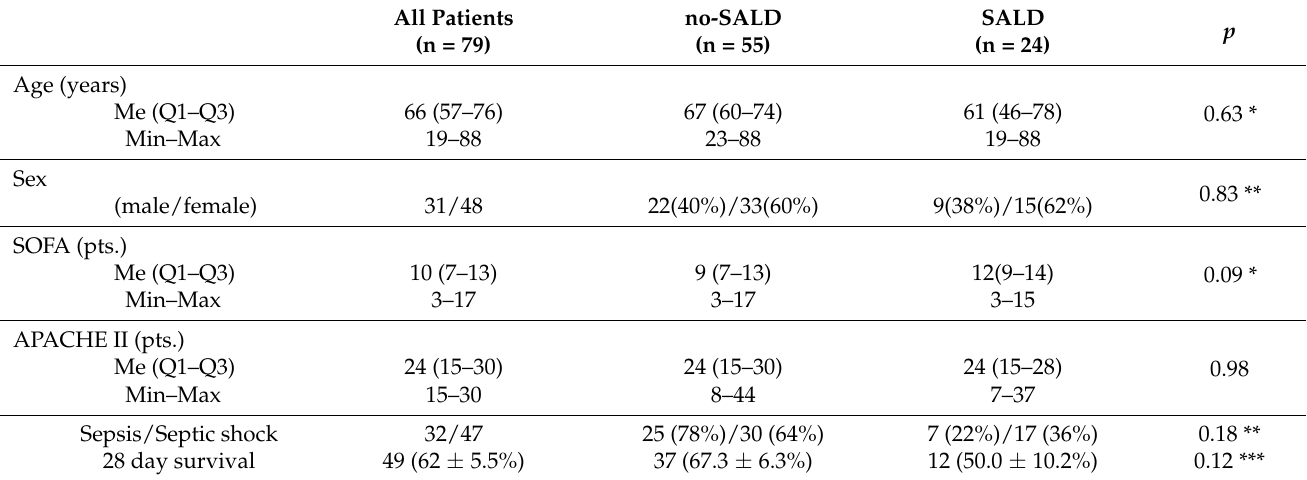
Table 1. Characteristics of the groups at the time of inclusion and 28 day survival.